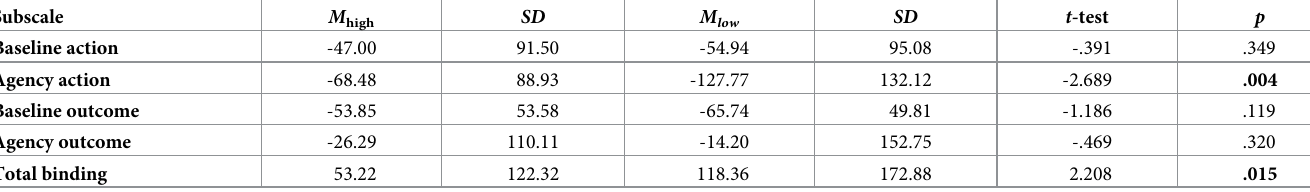
Table 3. Sense of agency and threatened